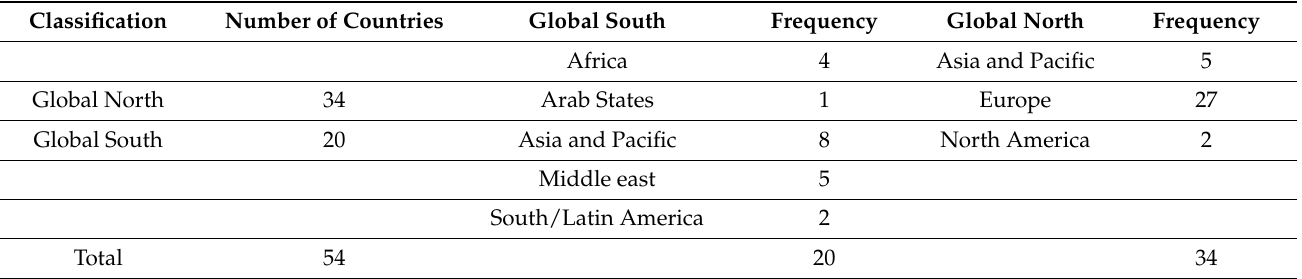
Table 2. Frequency of countries by publication.